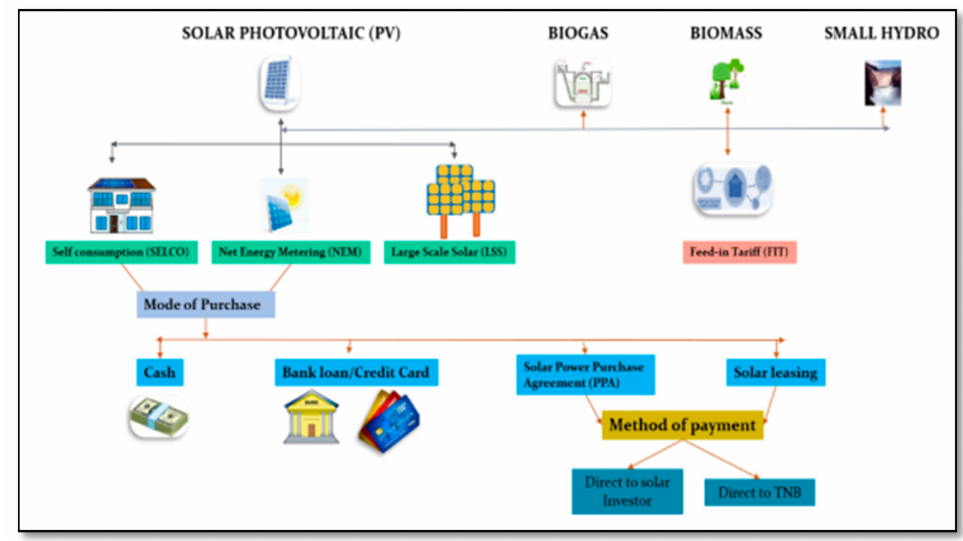
Figure 5. Implementation of program using different technologies to improve Renewable Energy